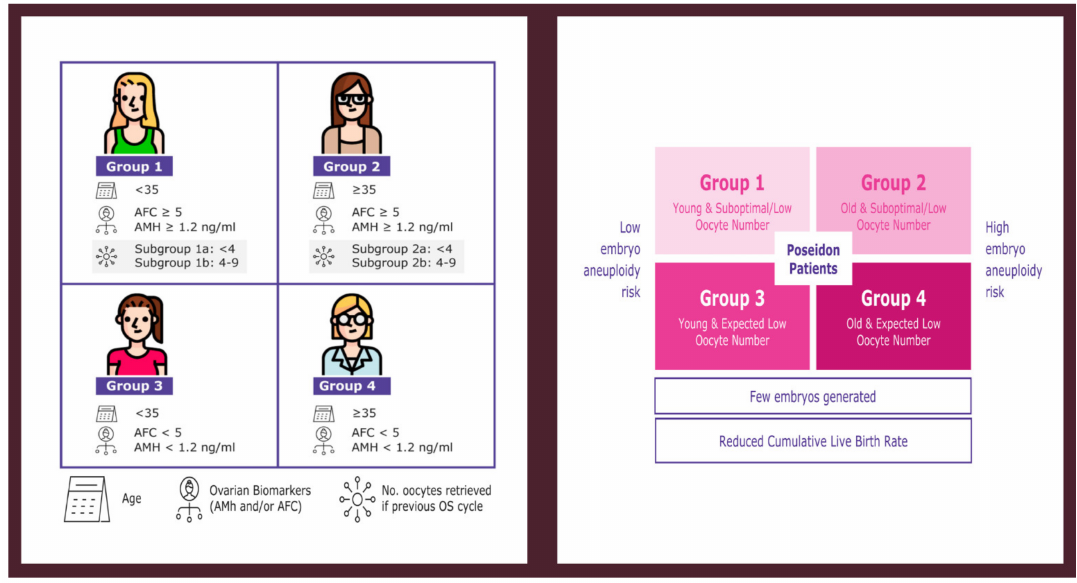
Figure 1. Patient-Oriented Strategies Encompassing IndividualizeD Oocyte Number (POSEIDON) criteria of low prognosis patients in Assisted Reproductive Technology (ART). The novel system relies on female age, ovarian reserve markers, ovarian sensitivity to exogenous gonadotropin, and the number of oocytes retrieved, which will both identify the patients with low prognosis and stratify such patients into one of four groups of women with “expected” or “unexpected” impaired ovarian response to appropriate exogenous gonadotropin stimulation. According to these criteria, four distinct groups of low prognosis patients can be established (left). Owing to low oocyte numbers and less embryos being produced, POSEIDON patients have lower cumulative live birth rates per started cycle than non-POSEIDON counterparts. However, the prognosis is di ff erentially a ff ected by female age as it relates to the risk of embryo aneuploidy (right). Art drawing by Chlo é Xilinas. Modified from Esteves et al. Front. Endocrinol. Esteves, S.C.; Roque, M.; Bedoschi, G.M.; Conforti, A.; Humaidan, P.; Alviggi, C. Defining low prognosis patients undergoing assisted reproductive technology: POSEIDON criteria—the why. Front. Endocrinol. (Lausanne) 2018 , 9 , 461. doi:10.3389 / fendo.2018.00461. This is